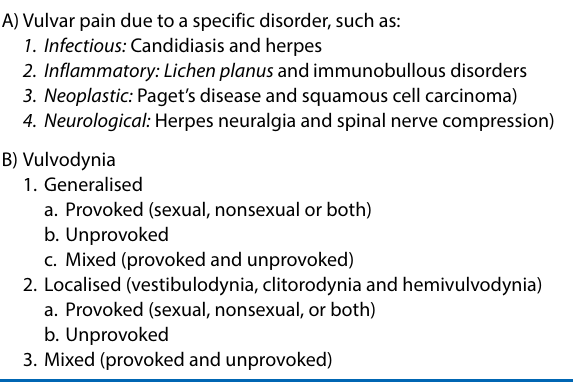
Table I: The 2003 classification of vulvar pain, according to the International Society for the Study of Vulvovaginal